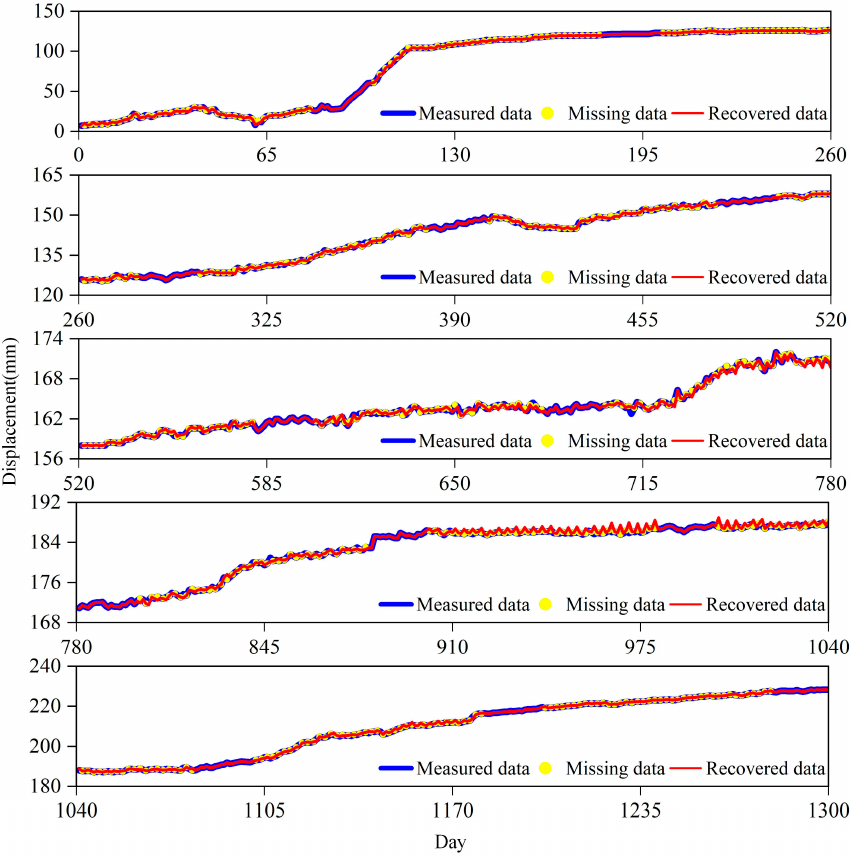
Figure 4. Completion of displacement data of SZY-08 (NM40%). The blue curve represents the measured data, the yellow dots represent the missing data and the red curve represents the recovered data.